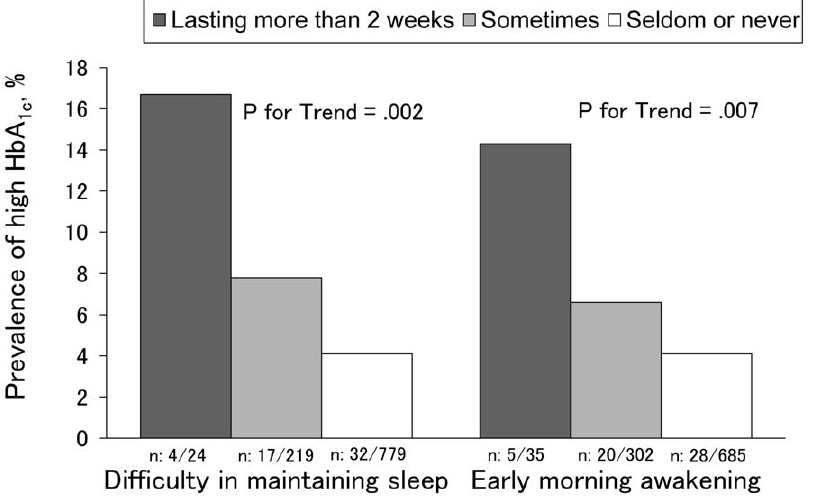
Figure 1. The prevalence of high HbA 1c across 3 categories of difficulty in maintaining sleep and early morning awakening. High HbA 1c is defined as a blood level of hemoglobin A 1c $ 6.0%. P values were obtained from the Mantel-Haenszel chi-square test for linear trend. doi:10.1371/journal.pone.0021420.g001 PLoS ONE |